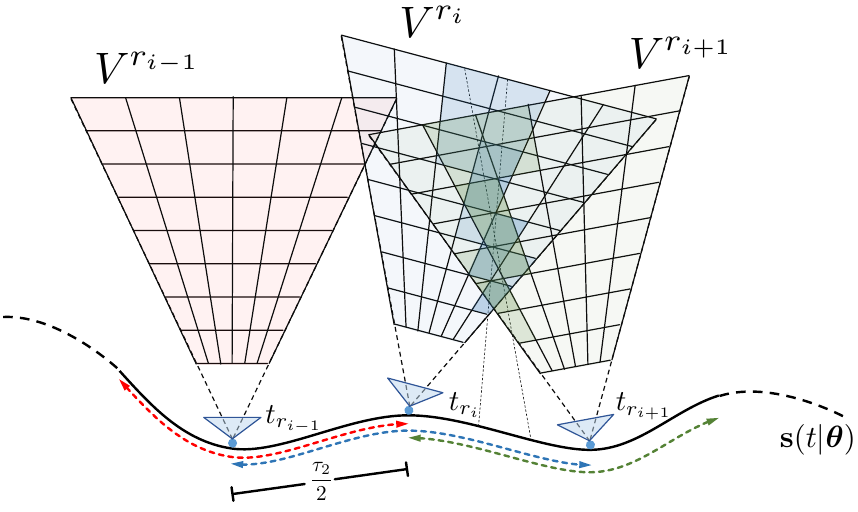
Figure 4. Global optimization over multiple reference volumes. The volumes may have spatial overlap. There is an individual time span [ t r V r i from which events will be considered (marked by the red, blue and green arrows). The time spans may have temporal overlap. Two events may hence both appear in two distinct density fields, which reinforces scale propagation in the